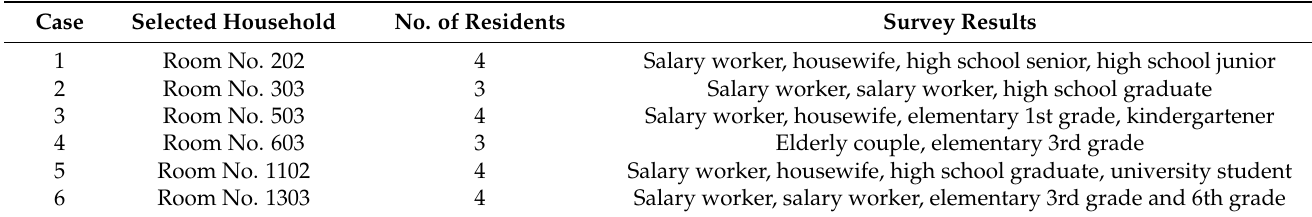
Table 10. Survey results of residents consuming the average heating energy.